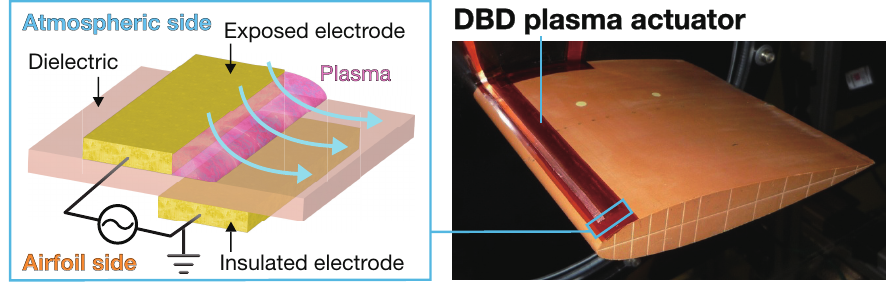
Figure 1. Schematic diagram of the DBD plasma actuator (PA) and the example of practical